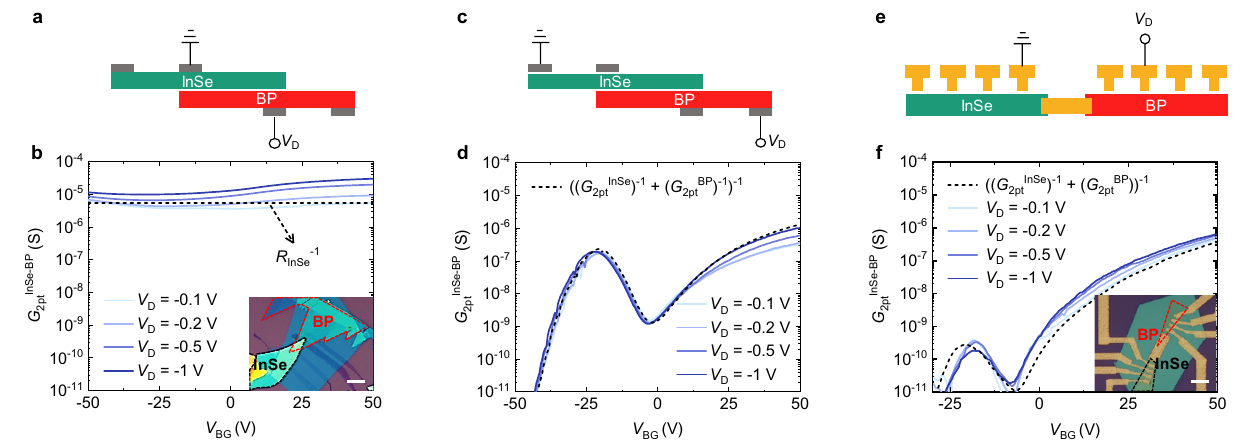
Figure 4. ( a ) Schematic describing the InSe-BP-FLG device and the measurement setup using the inner two electrodes. ( b ) G 2ptInSe−BP of the InSe-BP-FLG device measured as a function of V BG at different V D values, corresponding to the conductance of the InSe/BP overlap region. The inset shows an optical micrograph of the InSe-BP-FLG device (scale bar = 10 μm). ( c ) Schematic showing the measurement setup using the outer two electrodes of the InSe-BP-FLG device. ( d ) G 2pt InSe−BP of the InSe-BP-FLG device as a function of V BG at different V D values, corresponding to the conductance over the whole channel region, including the non-overlapped InSe and BP regions. ( e ) Schematic describing the InSe-Ti-BP-Ti device and corresponding measurement setup. ( f ) G 2pt InSe−BP of the InSe-Ti-BP-Ti device as a function of V BG at different V D values. The inset shows an optical micrograph of the InSe-Ti-BP-Ti device (scale bar = 10